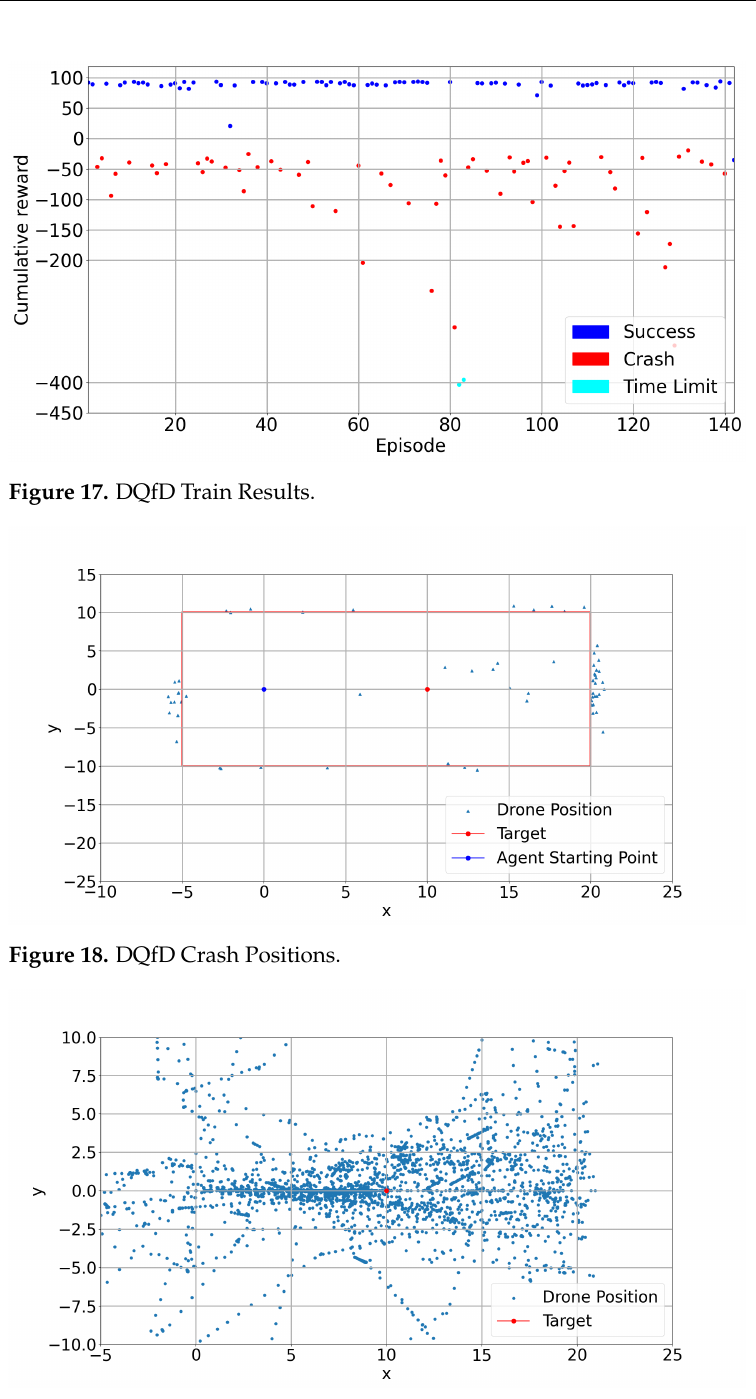
Figure 19. DQfD Drone